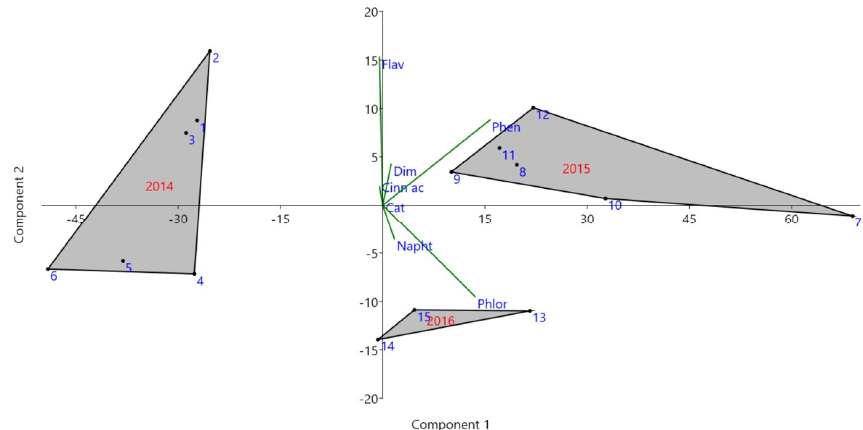
Figure 4. PCA biplot for the major groups of phenolic compounds detected in flowering tops of 3 H. perforatum biotypes, grown with two management systems and in three years. N = 15. Explained variance: PC1 = 92.1%; PC2 = 7.1%. Cinn— cinnamic acids; Phlor—phloroglucinols; Dim—dimers; Napht—naphthodianthrones; Cat—catechins; Flav—flavonols; Phen—phenols tot.